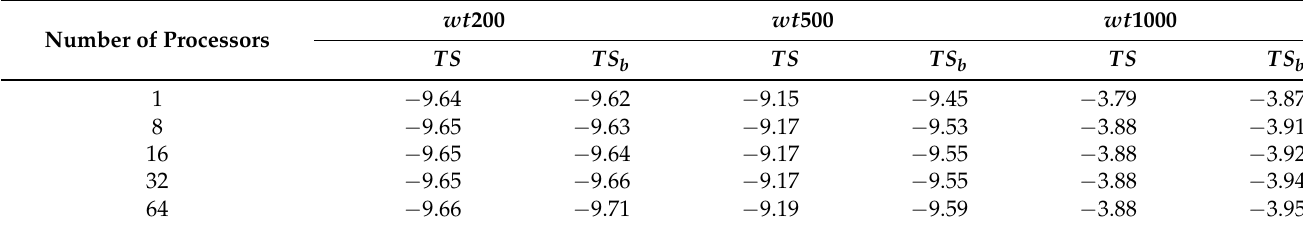
Table 3. Computational results for parallel tabu search algorithm ( t = 120 s, META as